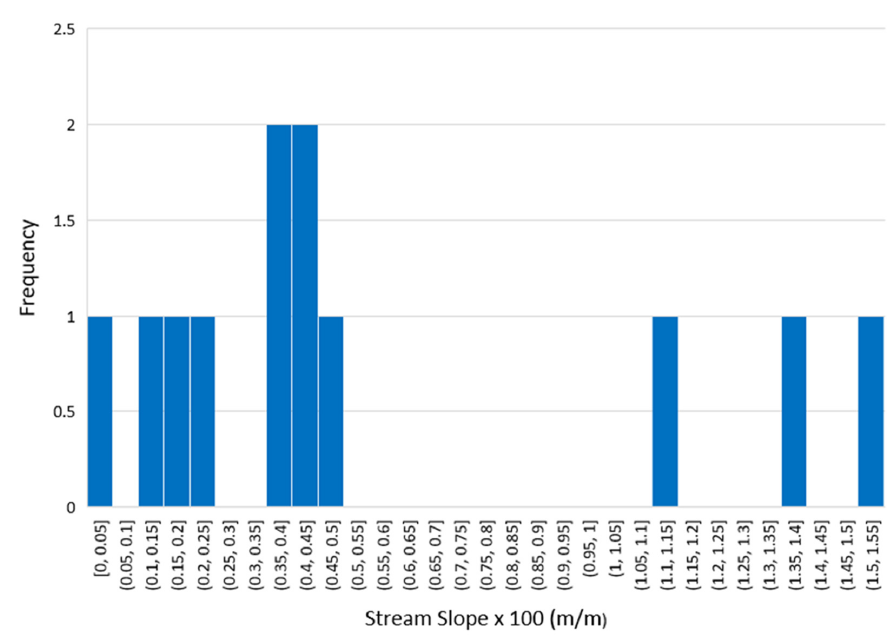
Figure A1. Stream slope at low head dams in Colorado with fatalities recorded.